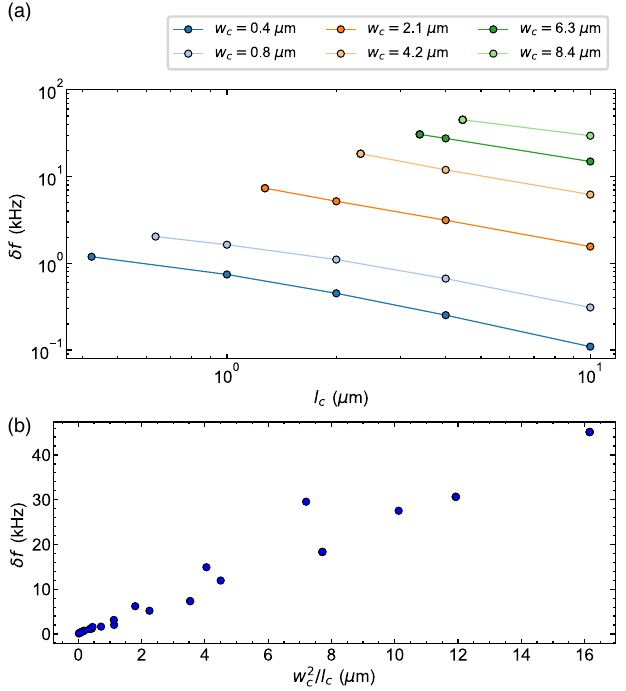
FIG. 16. Frequency splitting of dimers. (a) FEM simulation of mode splitting for varying coupler length ( l coupler widths ( w ). (b) Compilation of all the simulated values c =l in (a) plotted versus w 2 c c